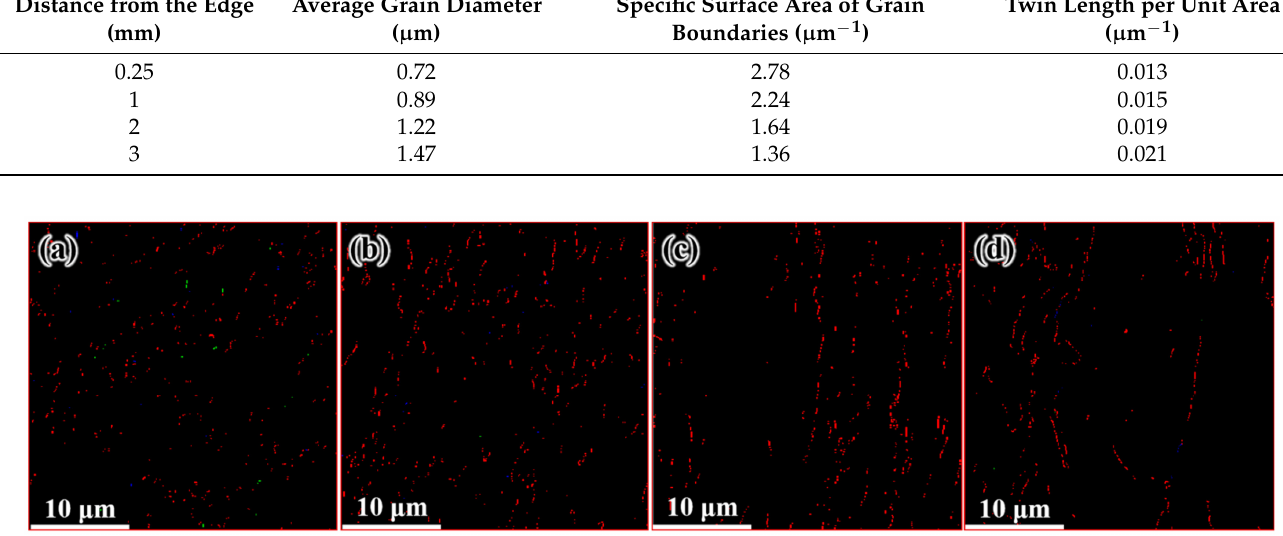
Figure 15. Distribution of twin boundary after FCE at room temperature: ( a ) 250 µ m from the edge, ( b ) 1 mm from the edge, ( c ) 2 mm from the edge, and ( d ) 3 mm from the